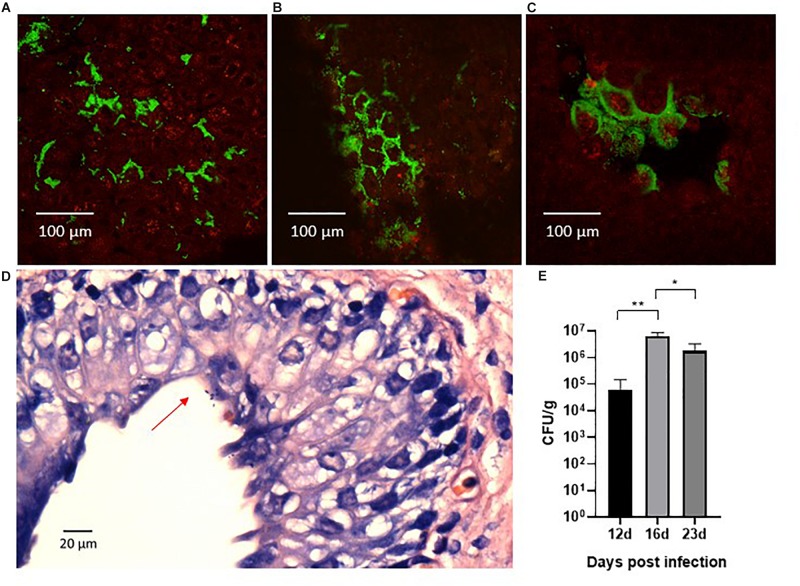
Confocal laser scanning microscopy of the surface of whole bladder sections after 12 h infection with the green fluorescent protein-expressing UTI89pMAN01. Large amounts of bacteria (green) were associated with the bladder tissue (red) although they were found in specific areas of swollen bladder epithelium (A). Large areas in between these infected areas were almost completely devoid of bacteria. The bacteria in infected areas were primarily located in deep pockets of the uroepithelium and inspection at higher magnification revealed that bacteria in general appeared localized to the boarders between the uroepithelial cells (B). At several sites, uroepithelial cells were covered in bacteria that were growing in biofilm-like structures (C). Histological examination revealed surface associated bacteria as well (D), although the above described distribution of bacteria made it difficult with this method to localize colonized sites (D). Whole bladder sections that were washed in PBS, homogenized and plated, showed significant quantities of bacteria associated with the bladder mucosa that persisted for prolonged infection experiments (E). Bars represents means ± standard errors of the mean.∗P < 0.01, ∗∗P < 0.0001, one-way ANOVA with Tukey’s multiple comparisons test. CFU, colony forming units.